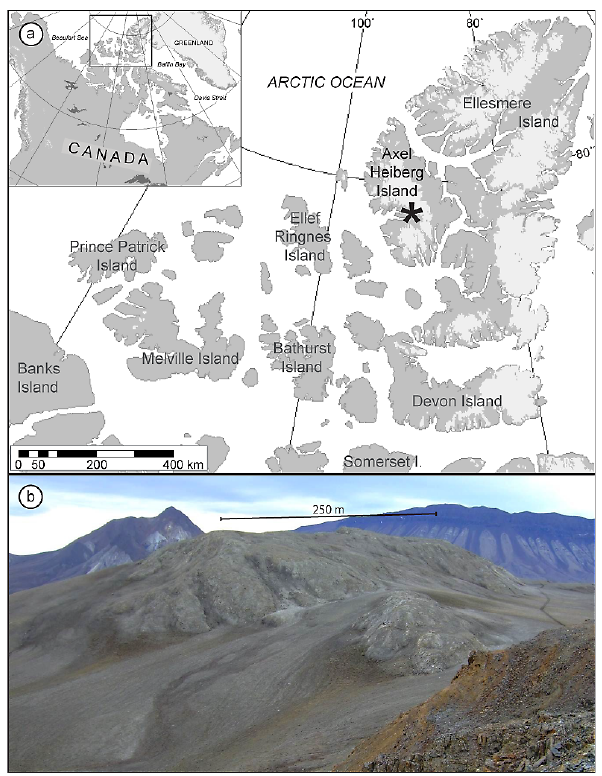
Fig. 1. (a) Study area map showing the location of Gypsum Hill diapir near the head of Expedition Fiord on western Axel Heiberg Island. (b) Photo of Gypsum Hill